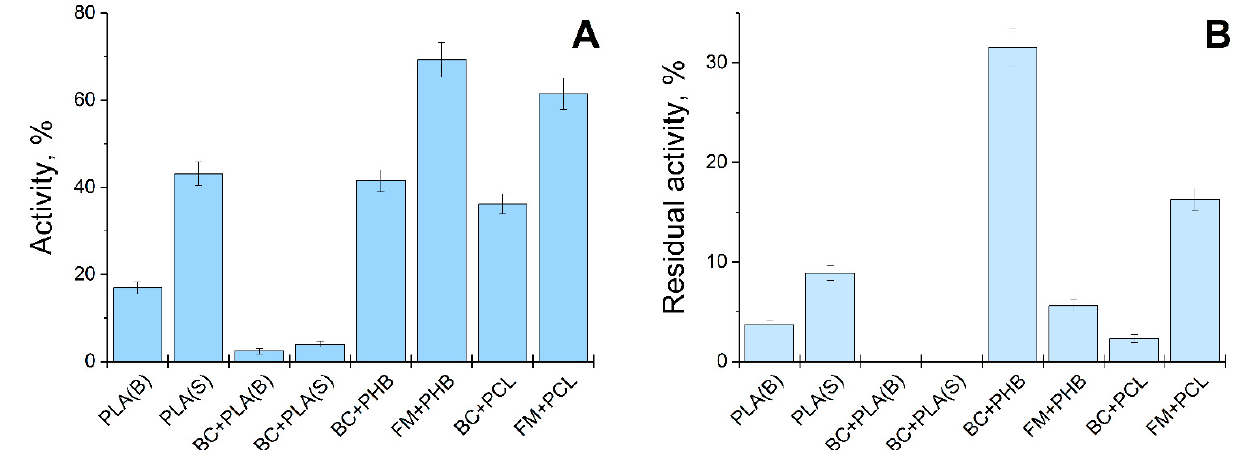
Figure 2. ( A ) OPH activity of composite materials based on polylactide fiber (PLA(S), PLA(B)), BC and FM modified with PLA(S), PLA(B), PCL or PHB and then functionalized by His 6 -OPH/PLE 50 . Enzyme activity deposited onto samples was accepted as 100%. ( B ) Residual OPH activity of the same samples after their single use and washing. Enzyme activity in the first working cycle was accepted as 100%.